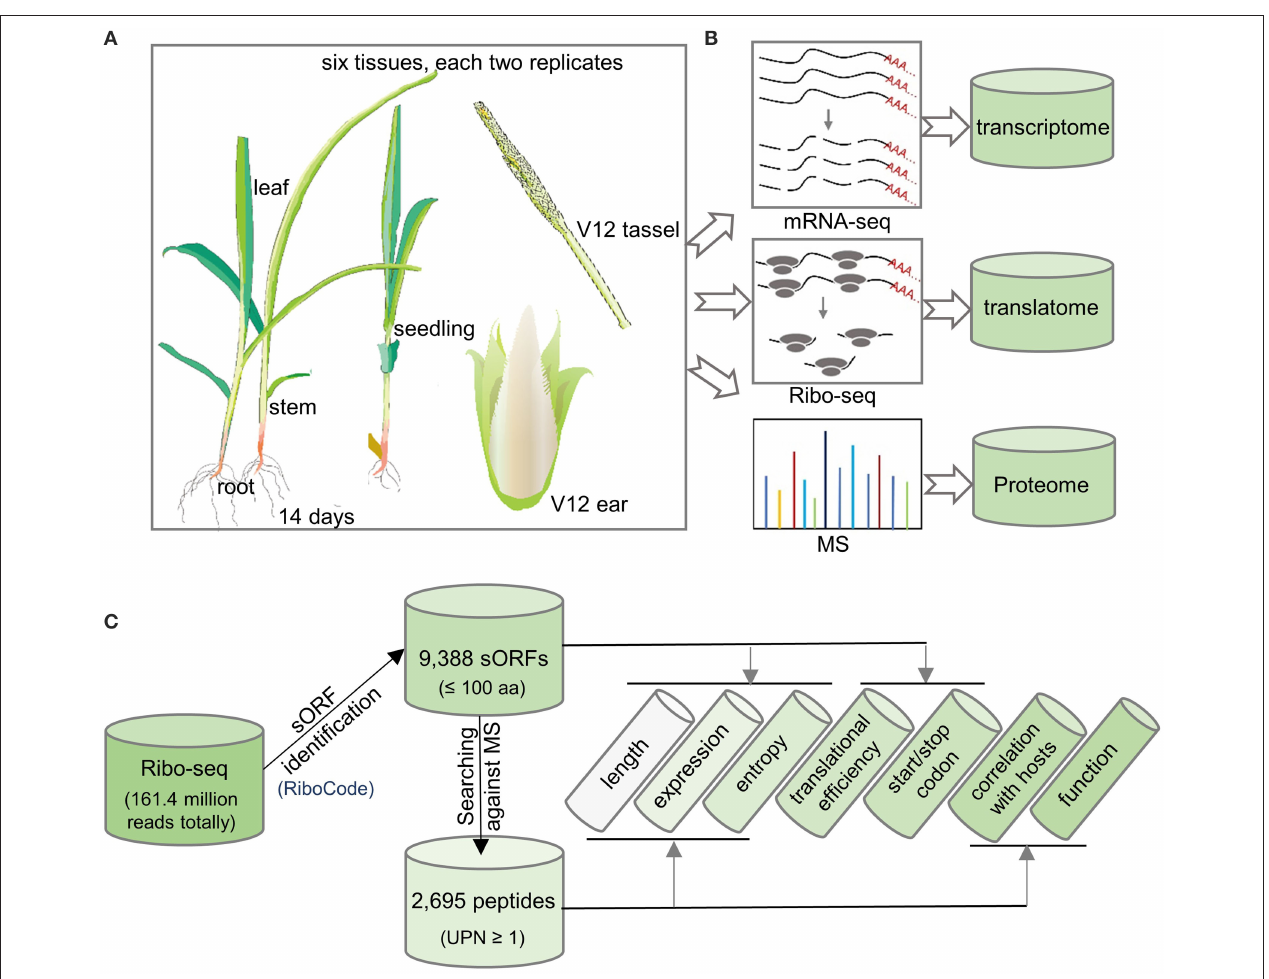
FIGURE 1 | Flowchart of experimentsfor the genome-wide identification of sORFs and sPeptides in maize. (A) Six tissues each with two replicates were analyzed in this study. (B) Multi-omics data, including transcriptome, translatome, and proteome, were collected for the detection of sORFs and sPeptides. (C) Bioinformatics pipeline used in this study to characterize the sORFs and